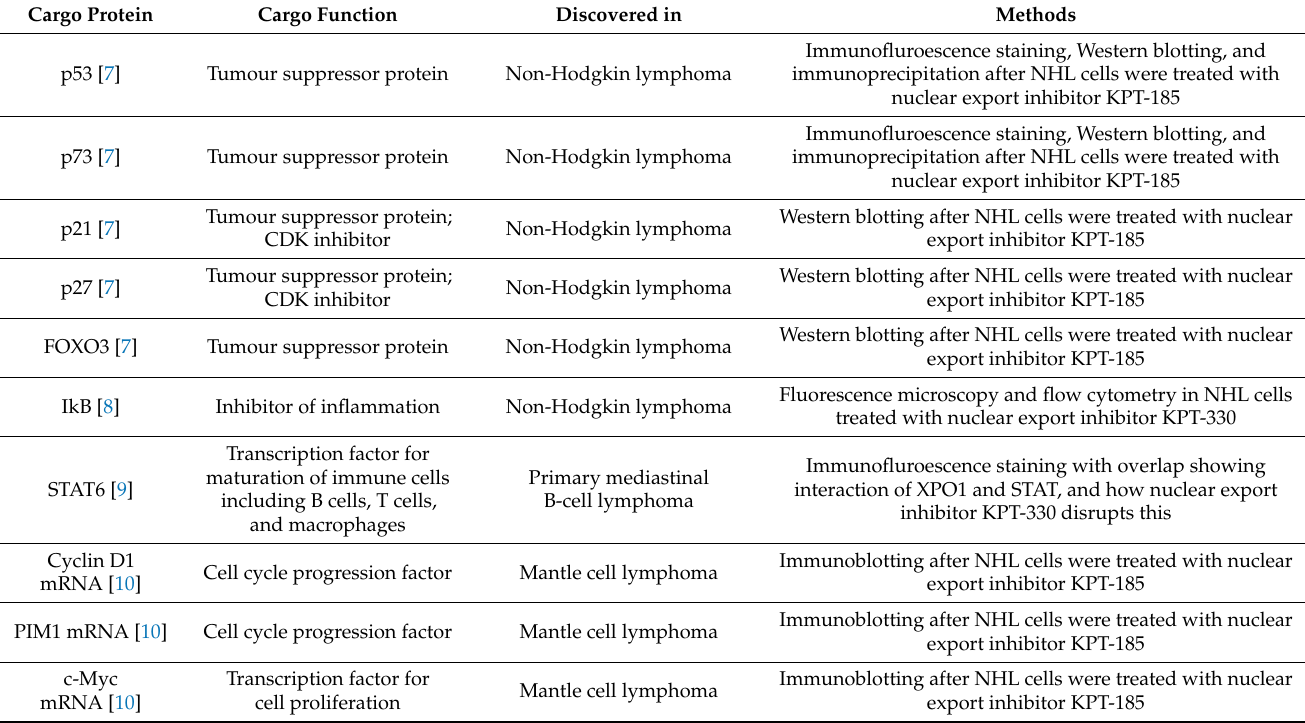
Table 1. XPO1 Cargo Identified in